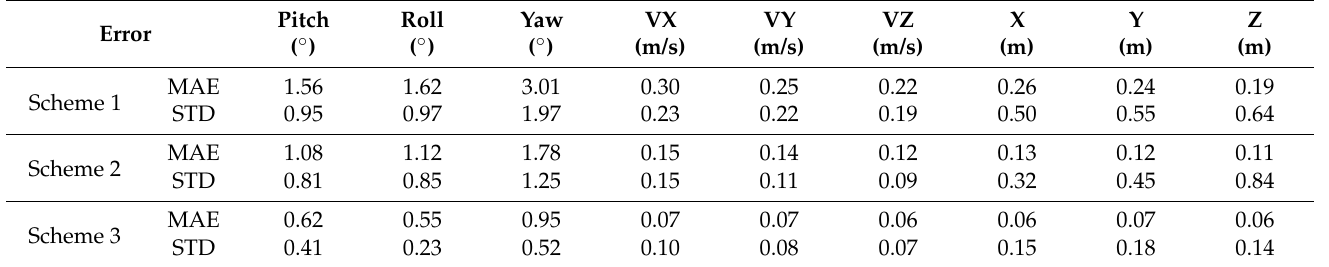
Table 5. Accuracy statistics of different schemes (the mean absolute errors (MAEs) and standard deviations (STDs) of the state estimation errors of the three